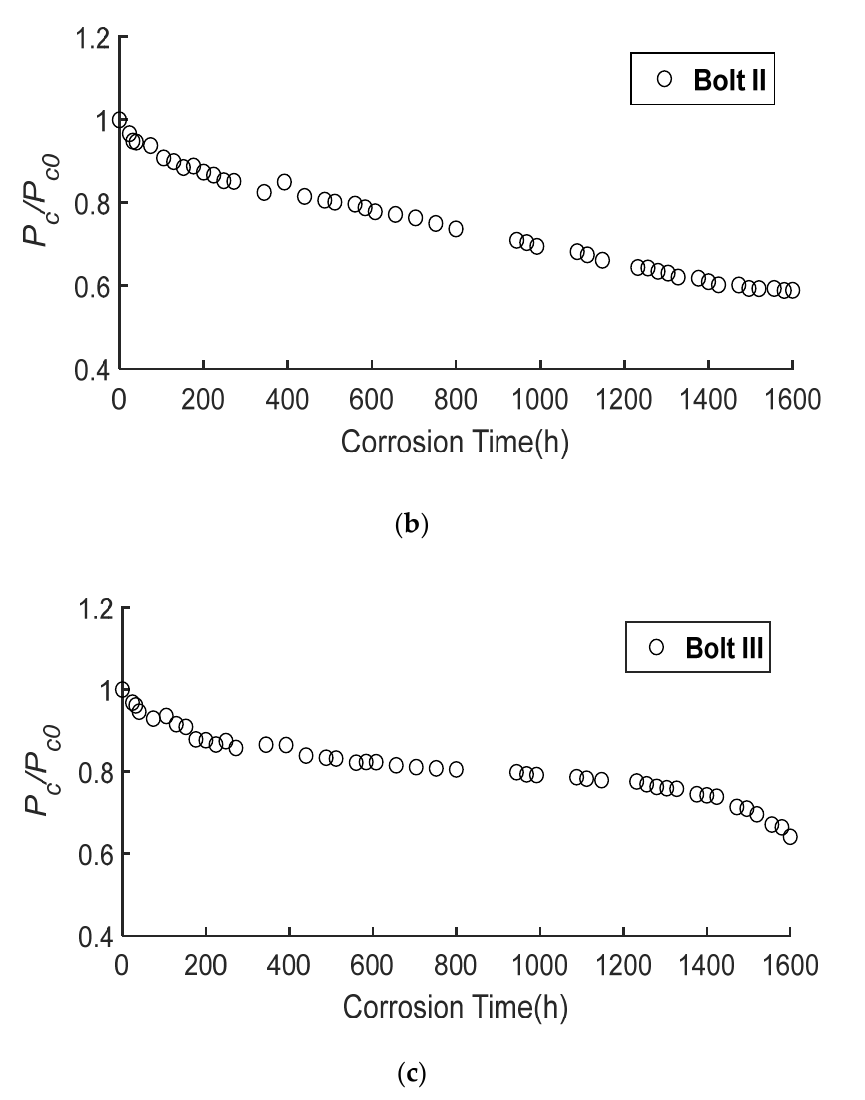
Figure 13. Preload ( P c / P c 0 ) versus corrosion time. ( a ) Bolt I; ( b ) Bolt II; ( c ) Bolt III. Table 6. Details of specimens in test.